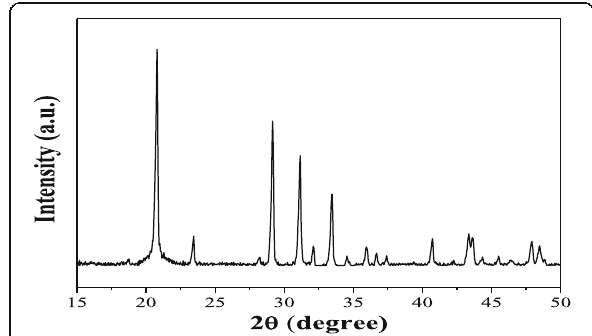
Fig. 1 X-ray diffractometer analysis of AgNPs that biofabricated by Pseudomonas fluorescens